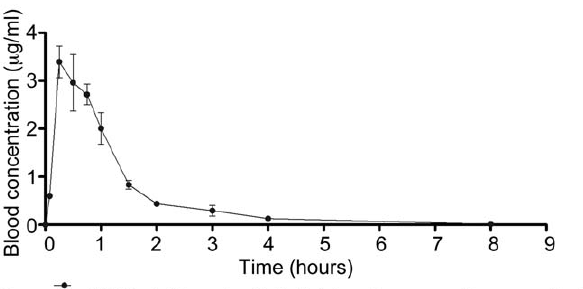
Figure 2. Whole blood pharmacokinetic profile and main parameters of IP 3 after oral administration of a 50 mg/kg suspension in 1% aqueous methylcellulose. Main pharmacoki- netic parameters were established after non-compartmental analysis: Cmax (maximum concentration observed in whole blood), 3.4 m g/ml; AUC (Area Under the Curve) (0–8 hours), 4.36 m g.h/ml; F (percentage